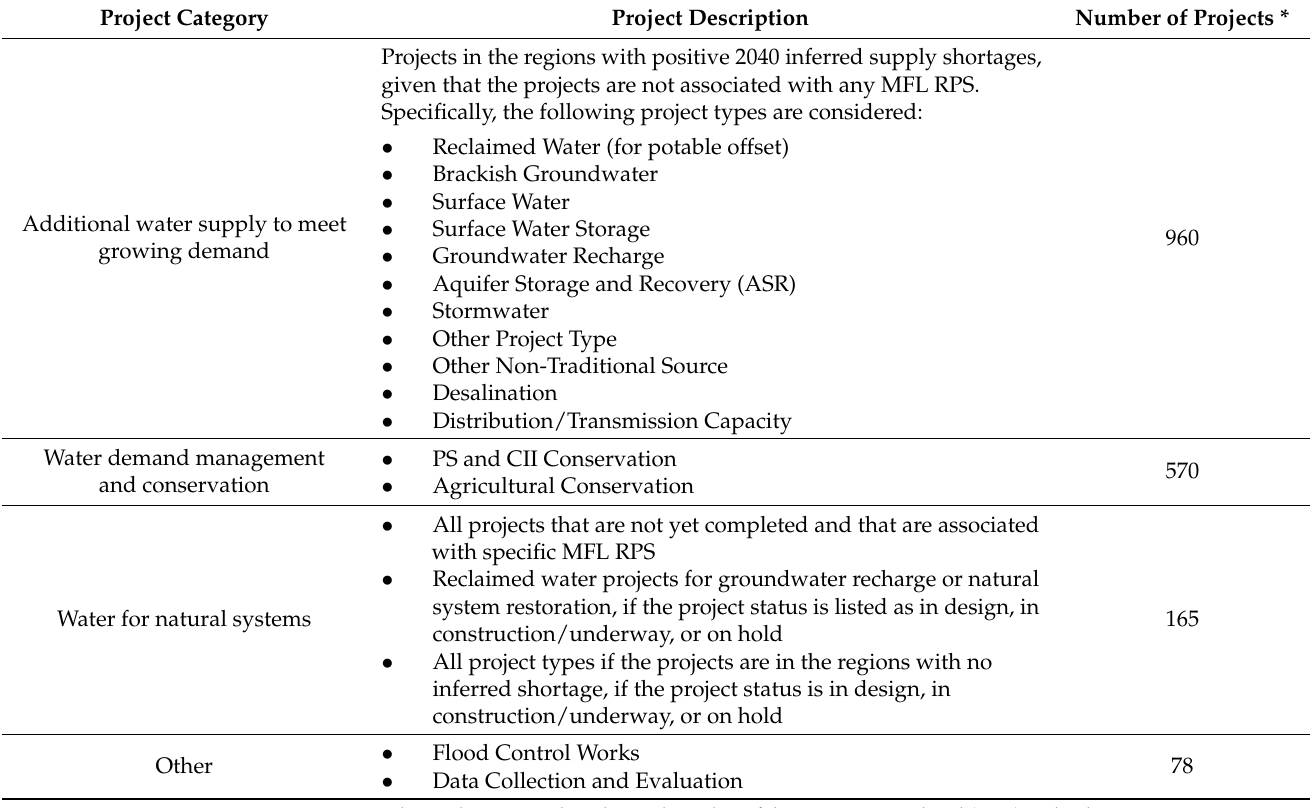
Table 2. General project categories used in this